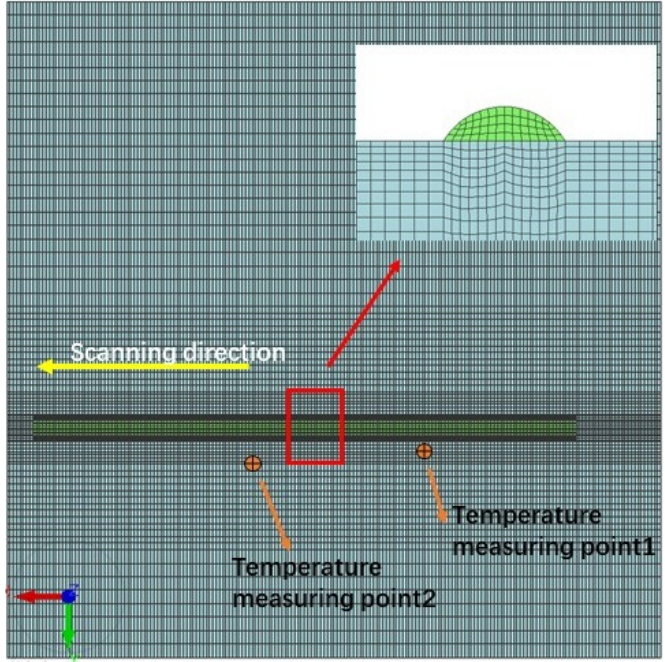
Figure 5. 3D physical model (top view). Table 3. Thermophysical properties of Ti-6Al-4V alloy.